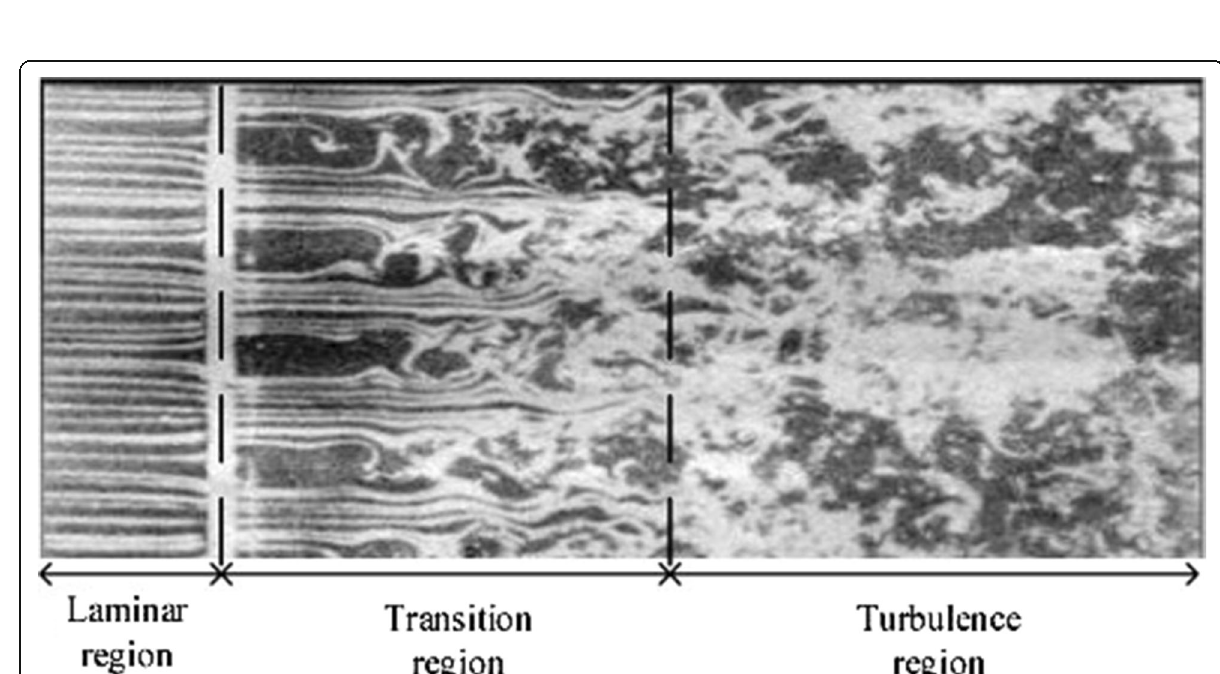
Fig. 10 The full development of wind turbulence